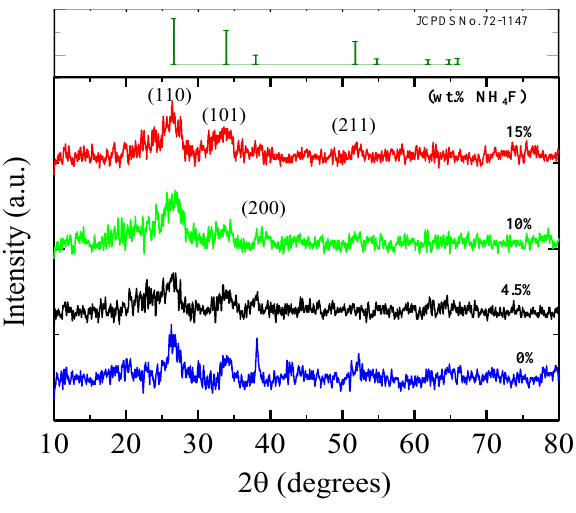
films deposited under different NH 2